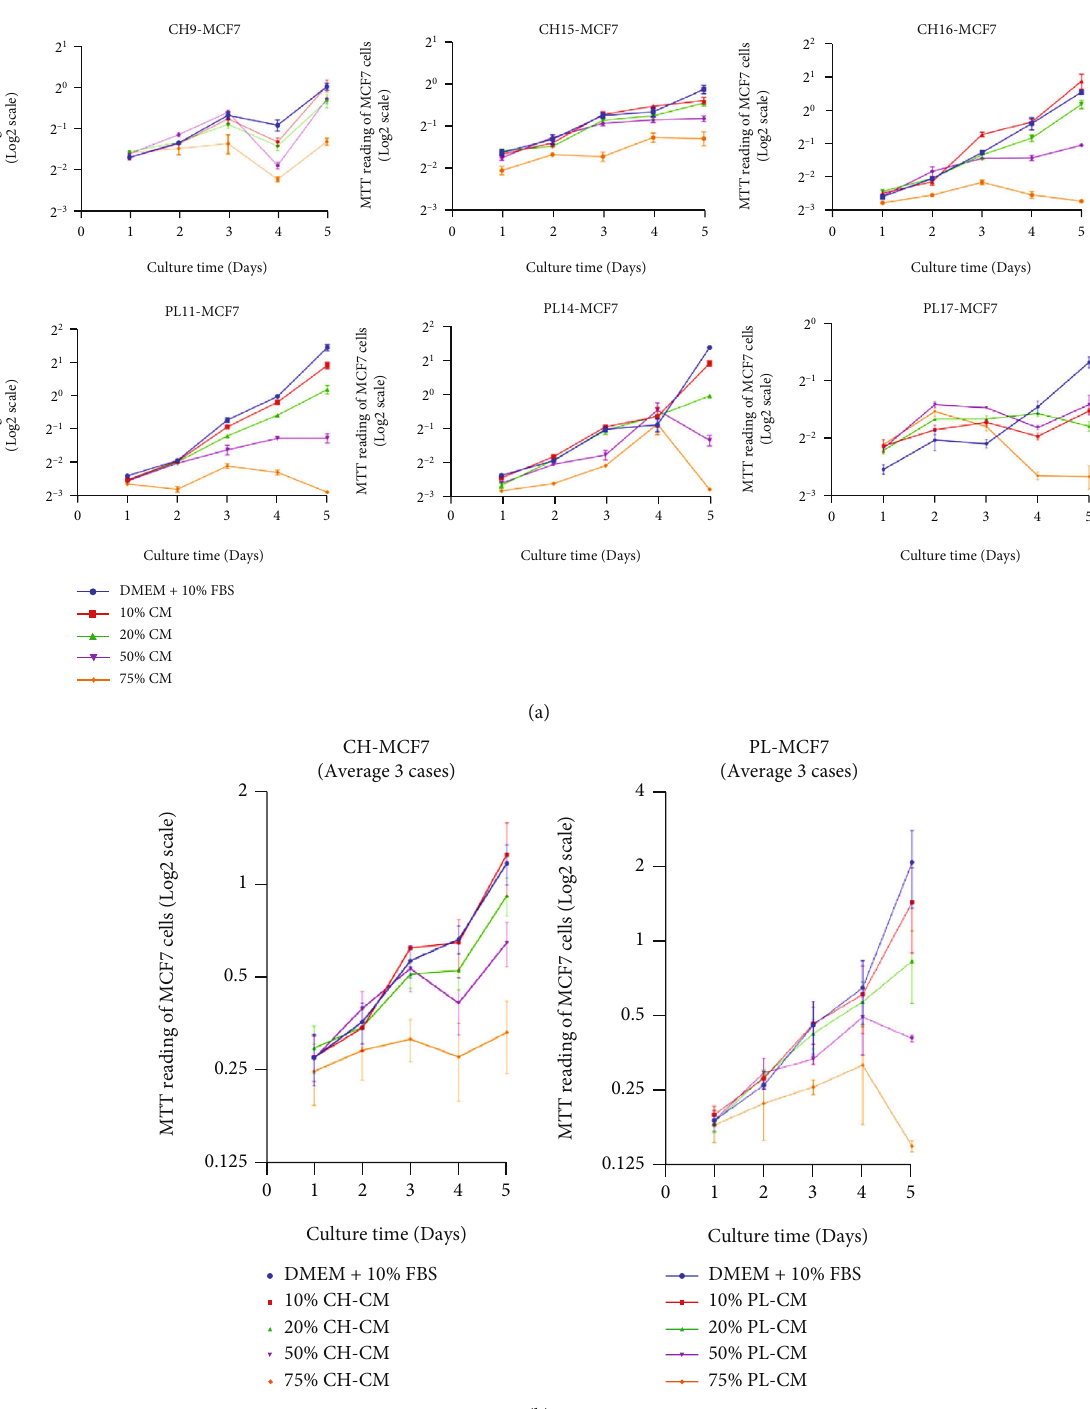
Figure 3: E ff ect of soluble factors derived from CH-hMSCs and PL-hMSCs on the proliferation of human breast cancer MCF-7 cells. (a) Graphs show the growth kinetics of MCF-7 cells cultured in 10%, 25%, 50%, and 75% conditioned media derived from CH-hMSCs (CH- CM) and PL-hMSCs (PL-CM) determined by the MTT assay. Data are presented as 6 of four experiments. MCF-7 cultured in DMEM medium +10% FBS served as controls. CH-CMs were prepared from 3 CH-hMSCs (CH9, CH15, and CH16) and PL-CMs were prepared from 3 PL-hMSCs (PL11, PL14, and PL17). (b) Graphs show the growth kinetic of MCF-7 cells cultured in 10%, 25%, 50%, and 75% CH-CM (average from CH9, CH15, to CH16) and PL-CM (average from PL11, PL14, to PL17). Data are presented as mean ± SEM of three hMSC-CMs. MCF-7 cultured in DMEM medium +10% FBS served as controls. ∗ P < 0 : 05 vs.